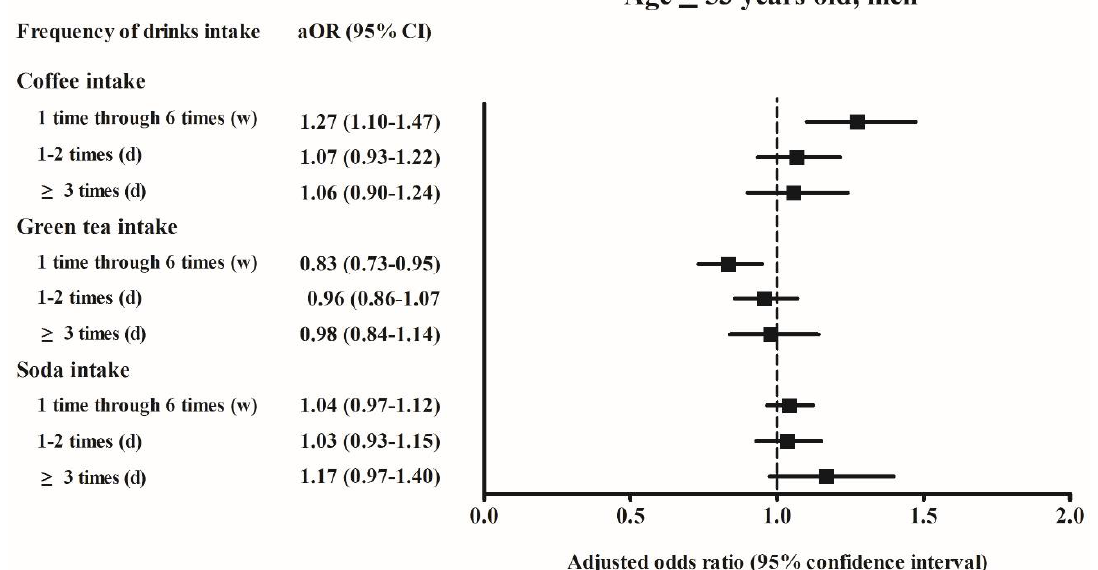
Figure 2. The adjusted odds ratio of the hyperuricemia according to the frequency of coffee/green tea/soda (soft drink) intake in the age ≥ 53 years old men. Fully-adjusted model (age, BMI, income, past medical histories, smoking, alcohol consumption, nutritional intake, frequency of coffee, green tea, and soft drink intake) was used.